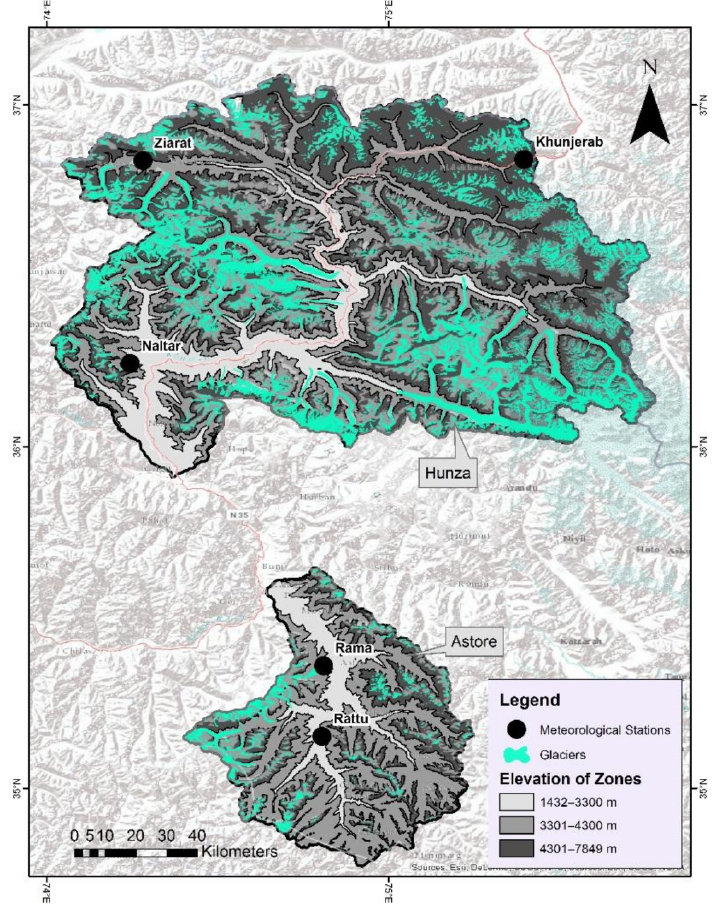
Figure 2. Showing three altitudinal zones of the Hunza and Astore River basins extracted from Global Digital Elevation Model (GDEM) along with glacier coverage and gauging